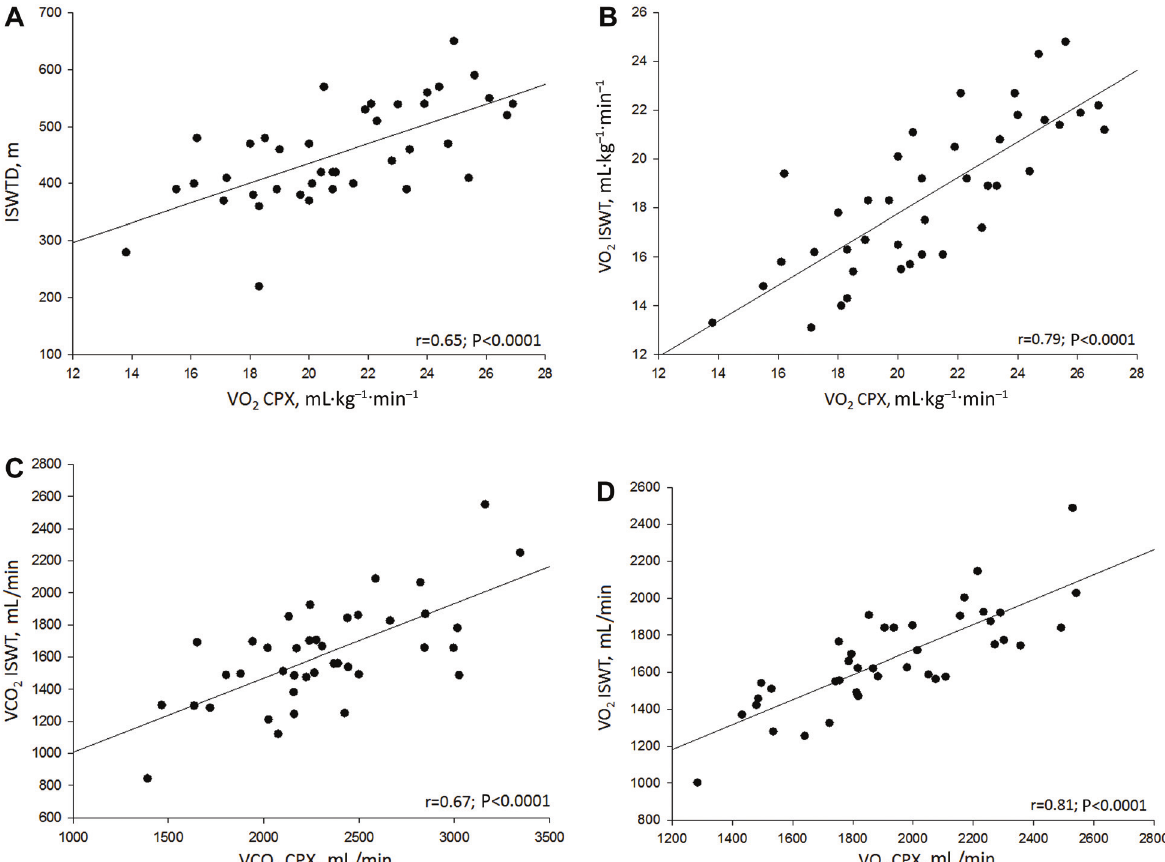
Figure 2. Pearson ’ s and Spearman ’ s correlation coef fi cients. A , correlation between ISWT distance and oxygen consumption in CPX in mL (cid:1) kg – 1 (cid:1) min – 1 ; B , correlation between oxygen consumption in ISWT and CPX in mL (cid:1) kg – 1 (cid:1) min – 1 ; C , correlation between carbon dioxide production in ISWT and CPX in mL/min; D , correlation between oxygen consumption in ISWT and CPX in mL/min. ISWT: incremental shuttle walk test; CPX: cardiopulmonary exercise testing; VO 2 : oxygen consumption; VCO 2 : carbon dioxide production.